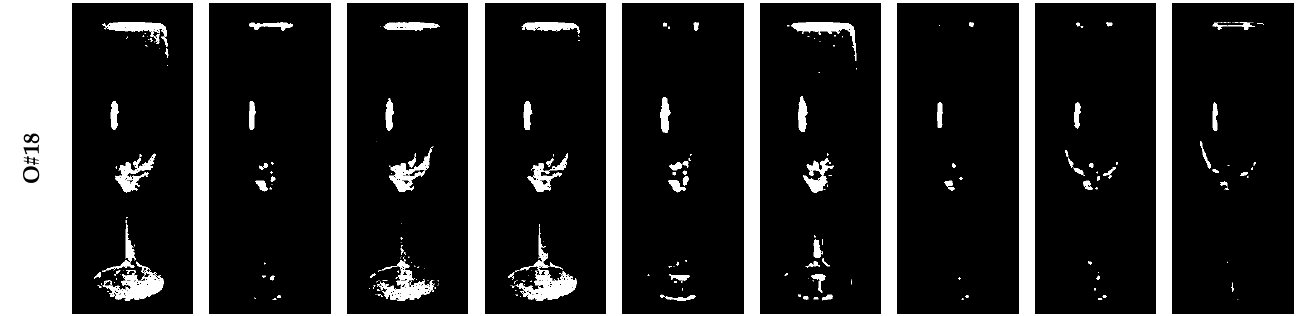
Figure A2. Comparison of SRD accuracies of different methods for sample objects in MSPLFI dataset.